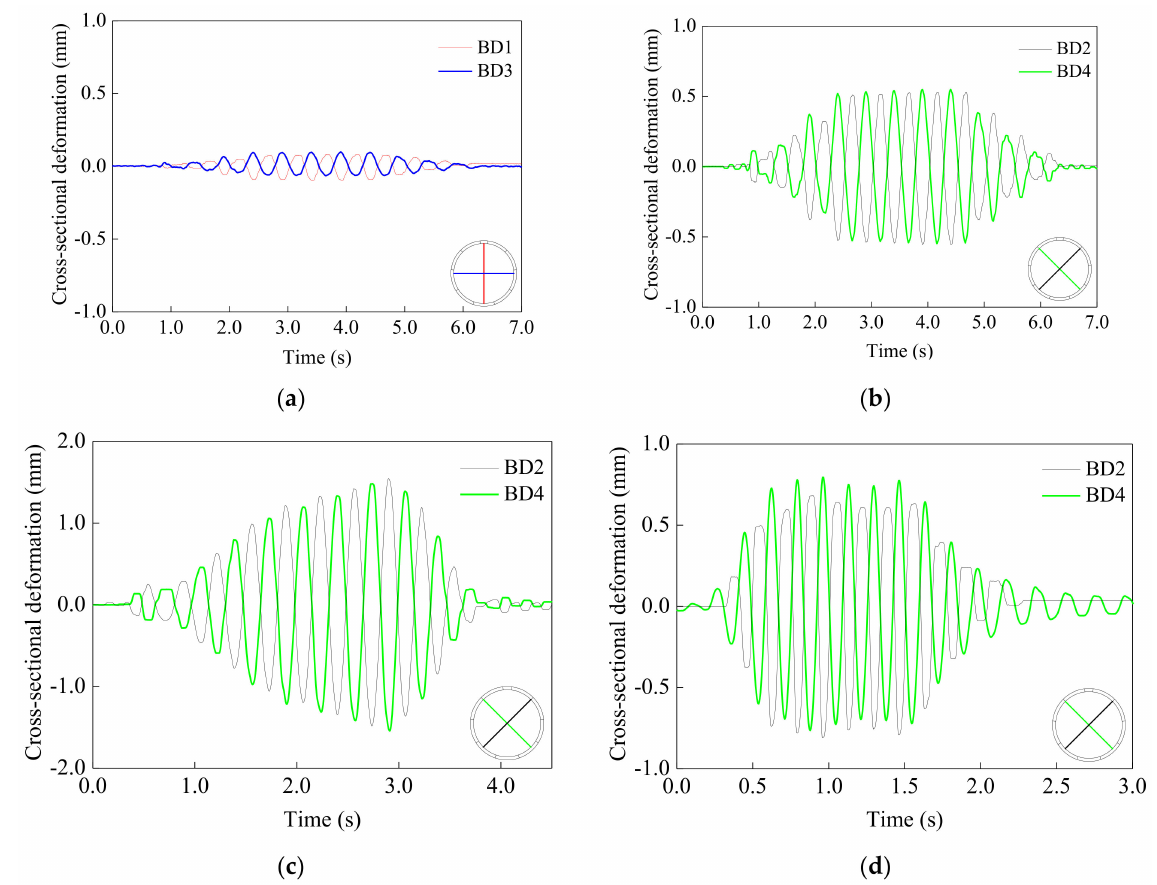
Figure 20. The cross-sectional deformation of segmental tunnel. ( a ) Sin-2 (BD1/BD3). ( b ) Sin-2 (BD2/BD4). ( c ) Sin-3 (BD2/BD4). ( d ) Sin-6